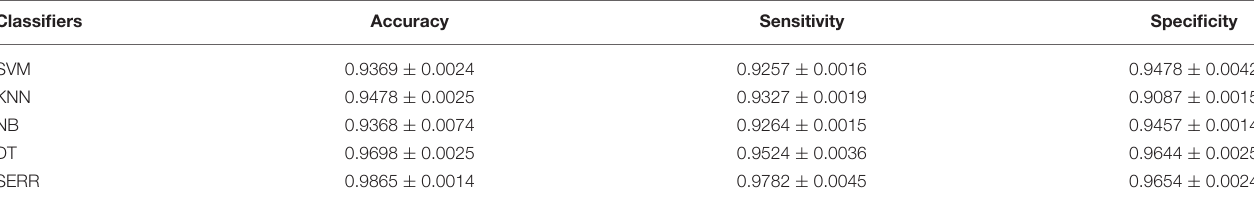
TABLE 6 | Classification performance of SERR, SVM, KNN, NB and